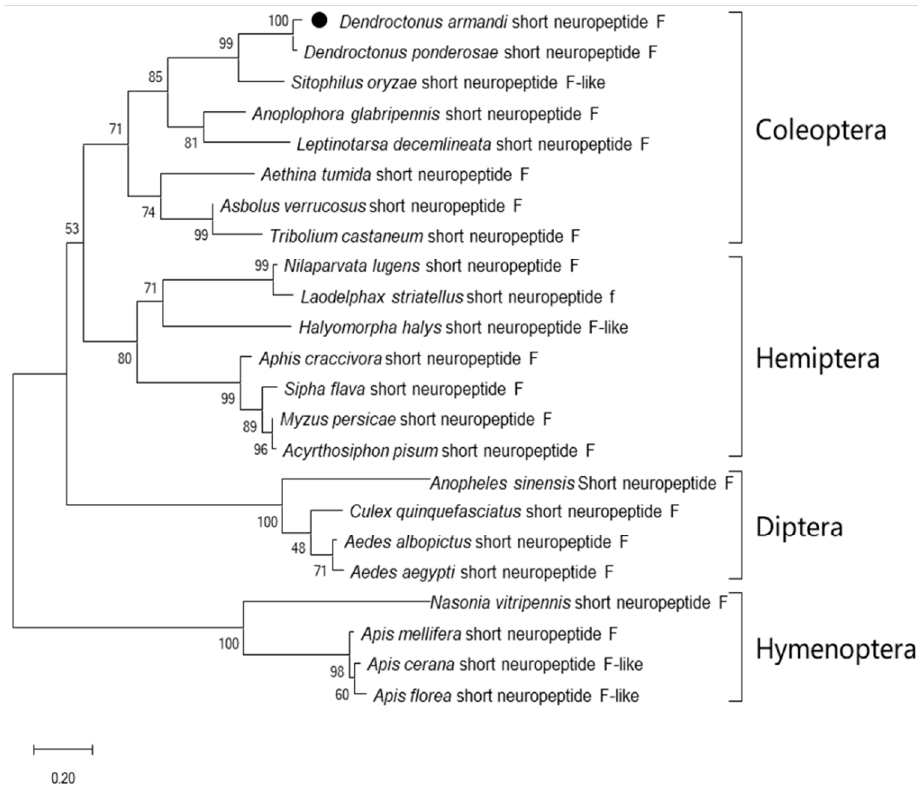
Figure 2. Phylogenetic trees based on amino acid sequences of sNPF from other insect species. They include Dendroctonus ponderosae (XP_019767920.1), Sitophilus oryzae (XP_030755875.1), Rhynchophorus ferrugineus (QGA72576.1), Anoplophora glabripennis (XP_018580111.1), Leptinotarsa decemlineata (XP_023021371.1), Aethina tumida (XP_019874673.1), Asbolus verrucosus (RZC41868.1), Tribolium castaneum (XP_008198705.1), Nilaparvata lugens (XP_022184541.1), Laodelphax striatellus (AXF48203.1), Sipha flava (XP_025411079.1), Myzus persicae (XP_022169760.1), Acyrthosiphon pisum (XP_003247250.1), Anopheles sinensis (KFB48121.1), Culex quinquefasciatus (AVR59281.1), Aedes albopictus (XP_029728321.1), Aedes aegypti (XP_021700214.1), Nasonia vitripennis (XP_008205837.1), Apis mellifera (XP_003250155.1), Apis cerana (XP_016914163.1), and Apis florea (XP_031773012.1). The phylogenetic tree constructed by the maximum likelihood method using the amino acidic substitution model WAG++G+I+F122 in MEGA5.0. Bootstrap values after 500 pseudo-replicates are shown at nodes. The bootstrap values (in %) are given at each branch point. The black dot indicates D. armandi sNPF.